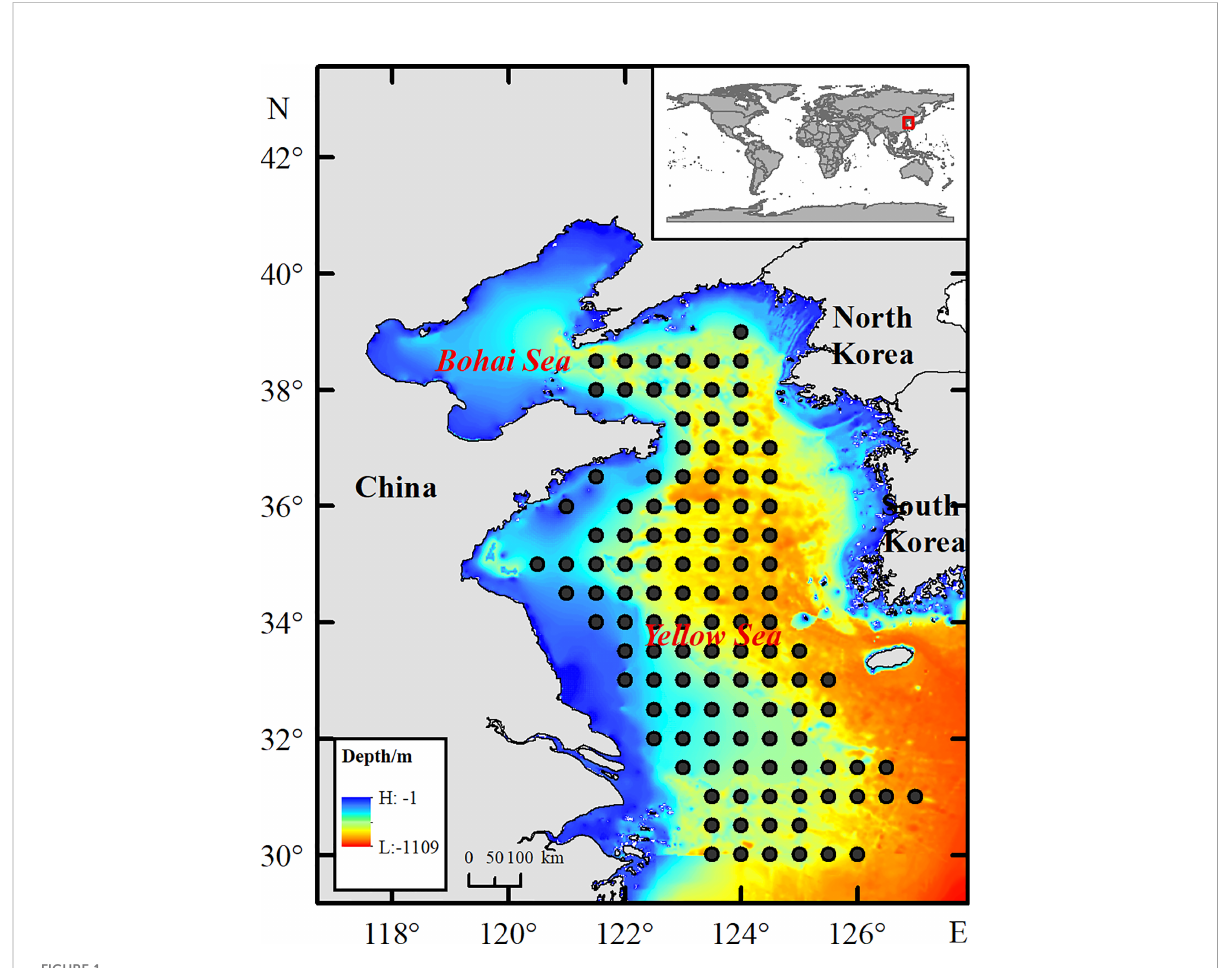
FIGURE 1 Schematic illustration of the survey sites in the Yellow